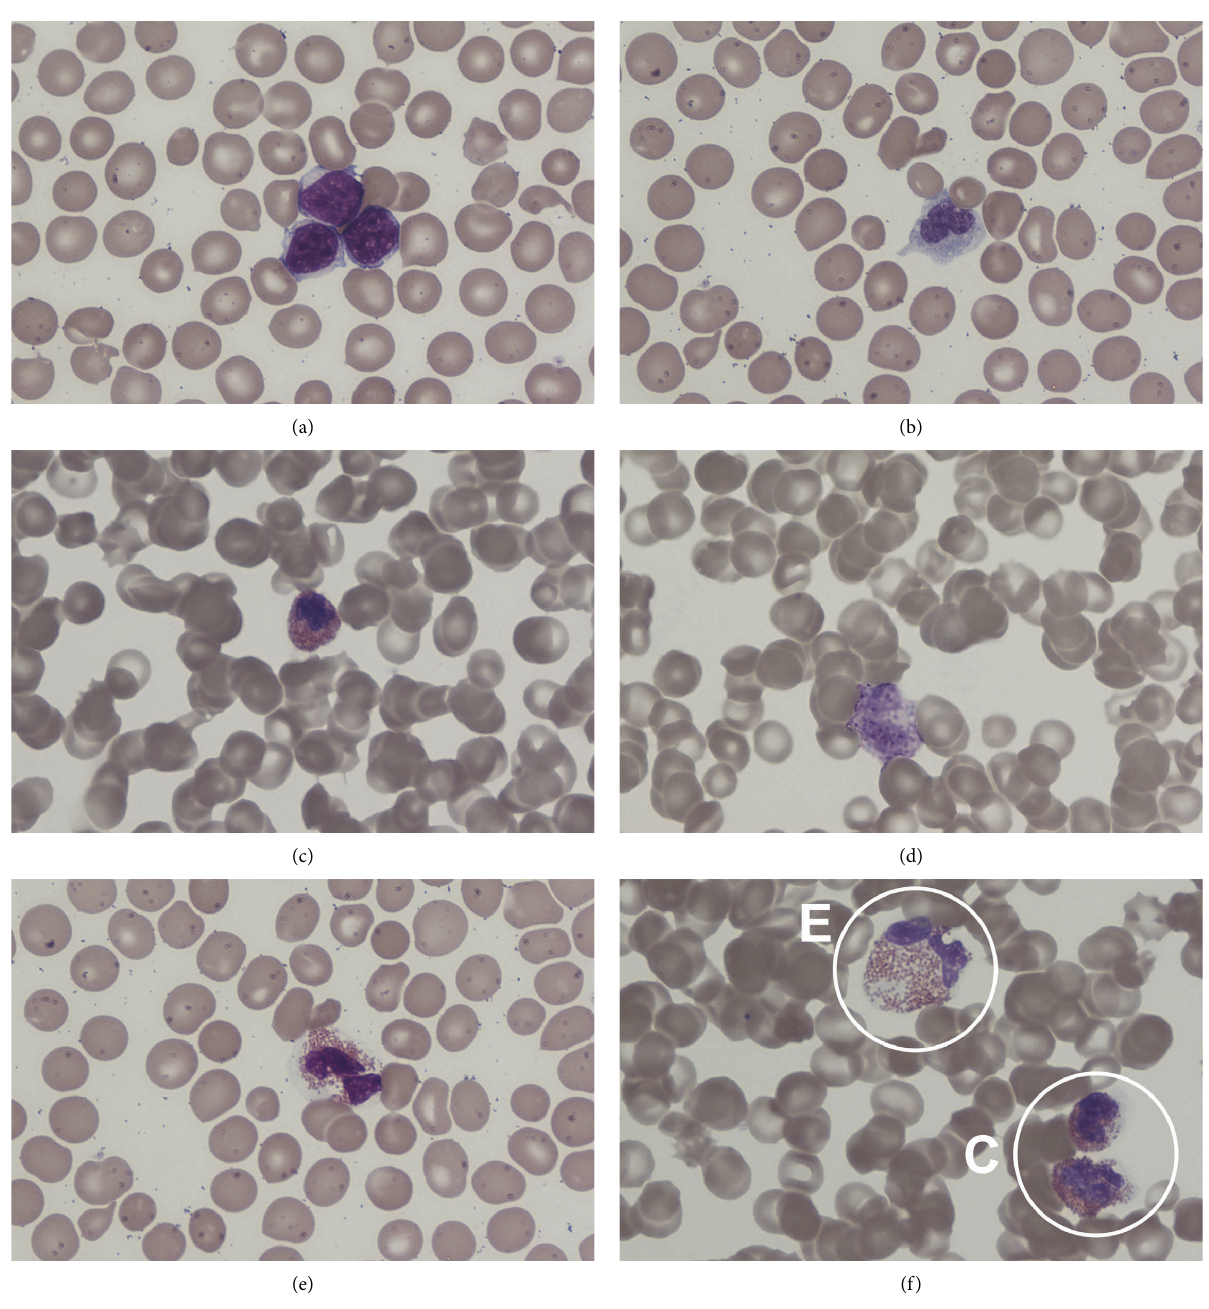
Figure 5: White blood cell types from an Antillean manatee from Puerto Rico: (a) lymphocytes, (b) monocyte, (c) eosinophil, (d) basophil, (e) heterophil, and (f) comparison between a heterophil (E) and two eosinophils (C). Wright-Giemsa, x100